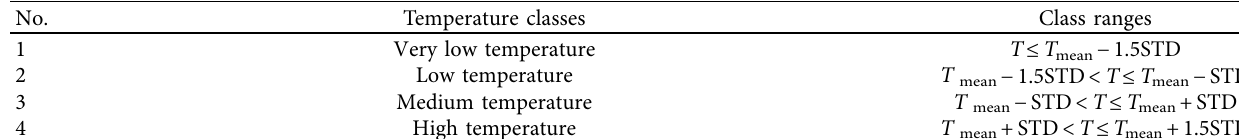
Figure 6: Changes in LST of Banjarmasin City in 2015 and 2019. Table 3: Classifcation of the surface temperature.